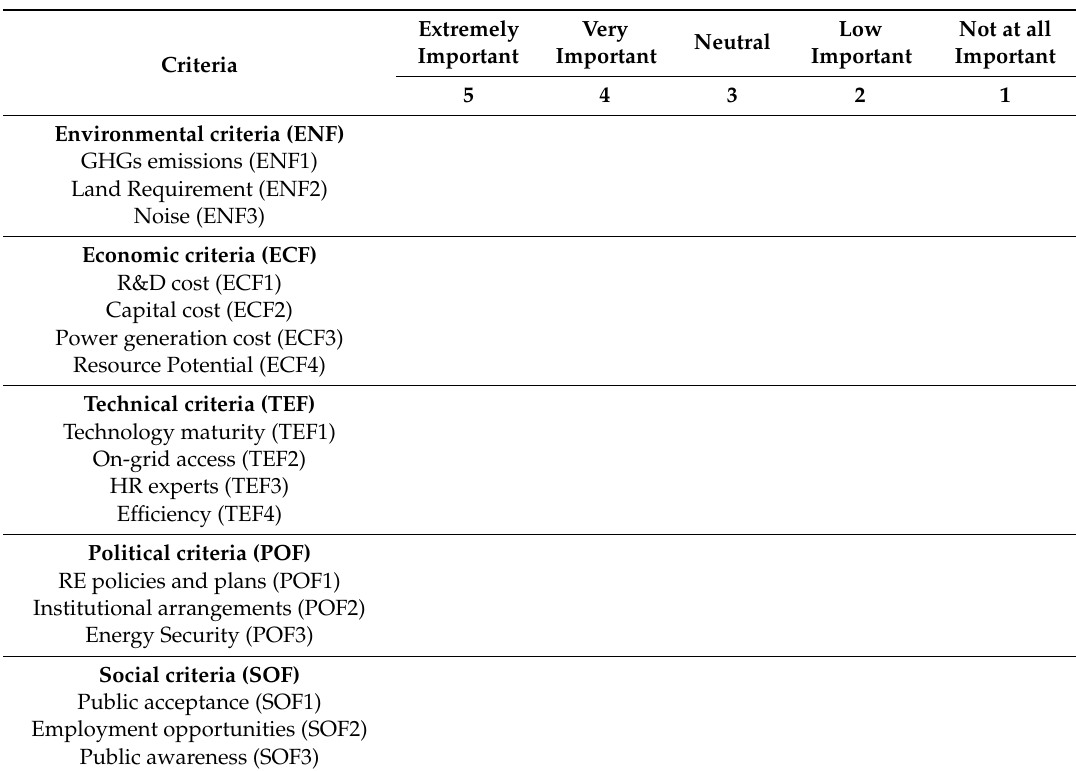
Table A1. Please rate the opinion on a five-point Likert scale on the following criteria in terms of their importance in analyzing RE sources. Criteria